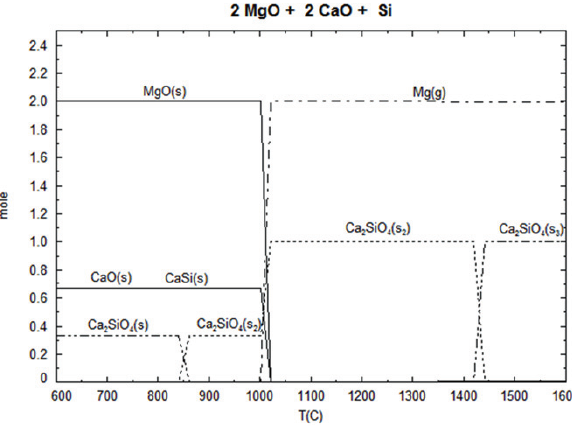
Figure 7. Silicothermic reduction of dolime under 1 (cid:2) 10 2 Pa at different temperatures [14].